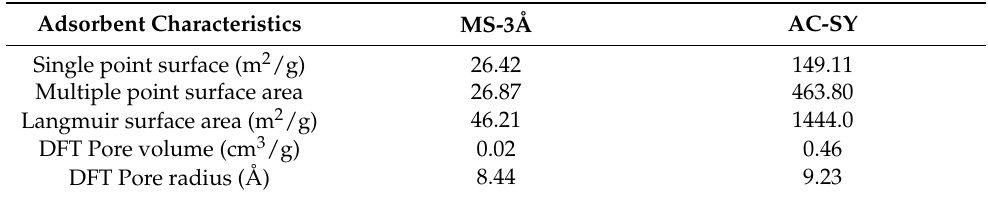
Table 2. Surface characterizations of MS-3Å and AC-SY.